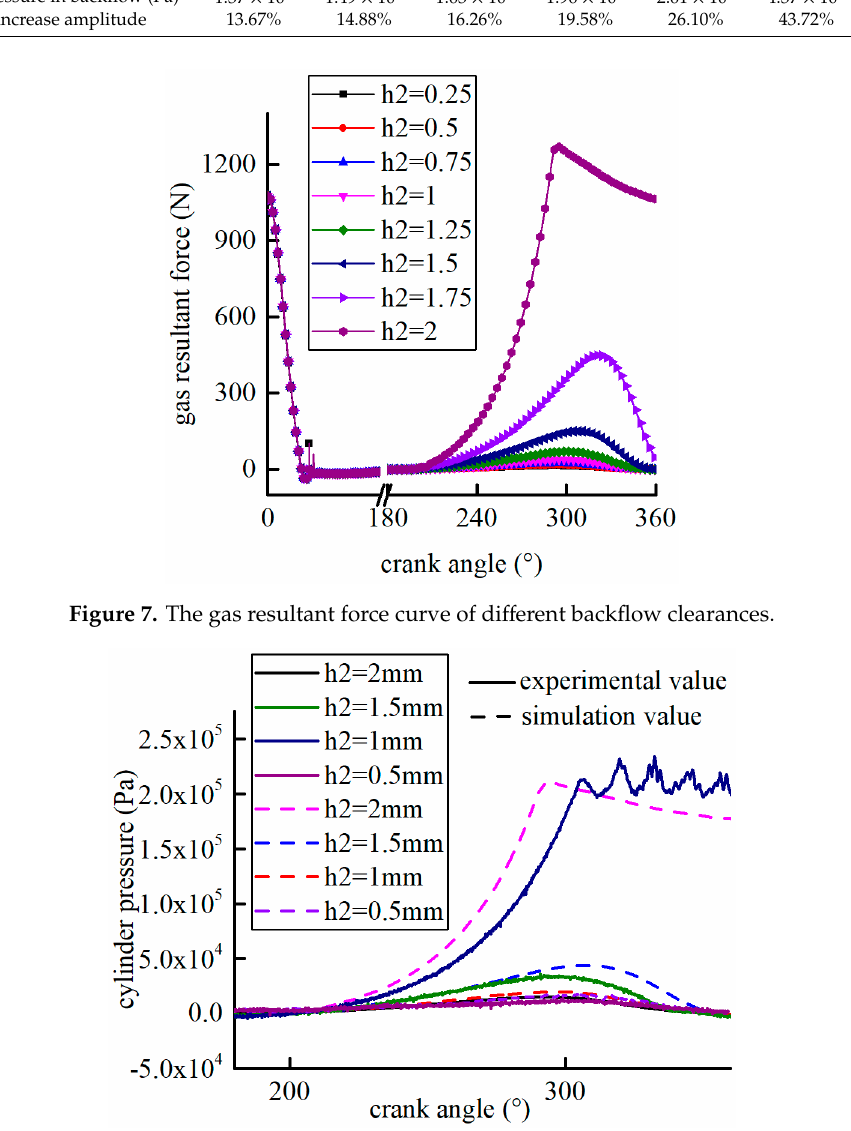
Figure 8. Experimental and simulation curves.